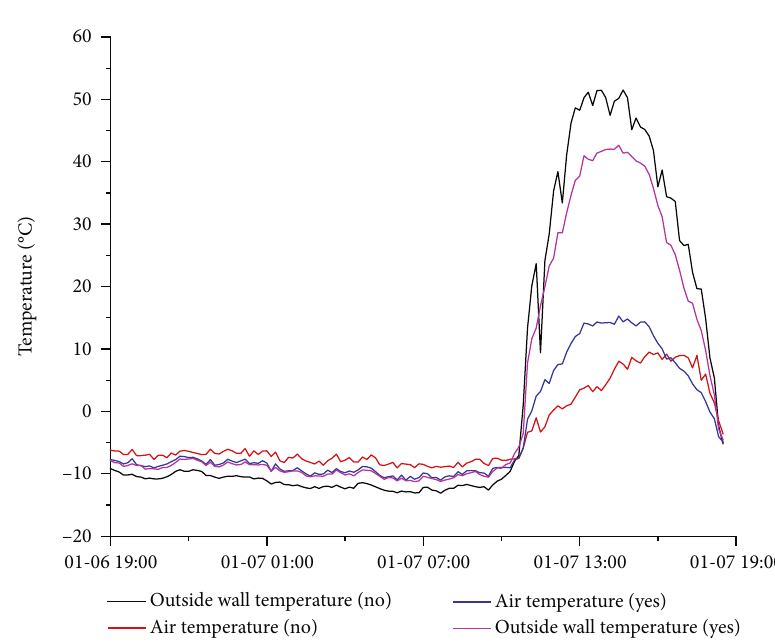
Figure 11: Temperature comparison when the fan